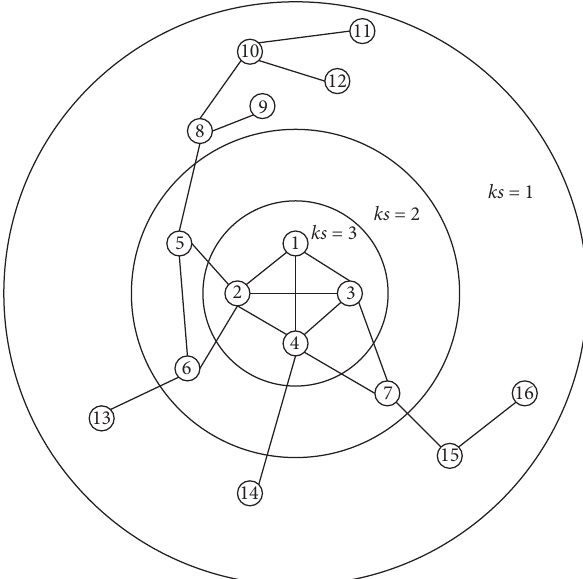
Figure 1: The schematic diagram of basic principles of the k-shell